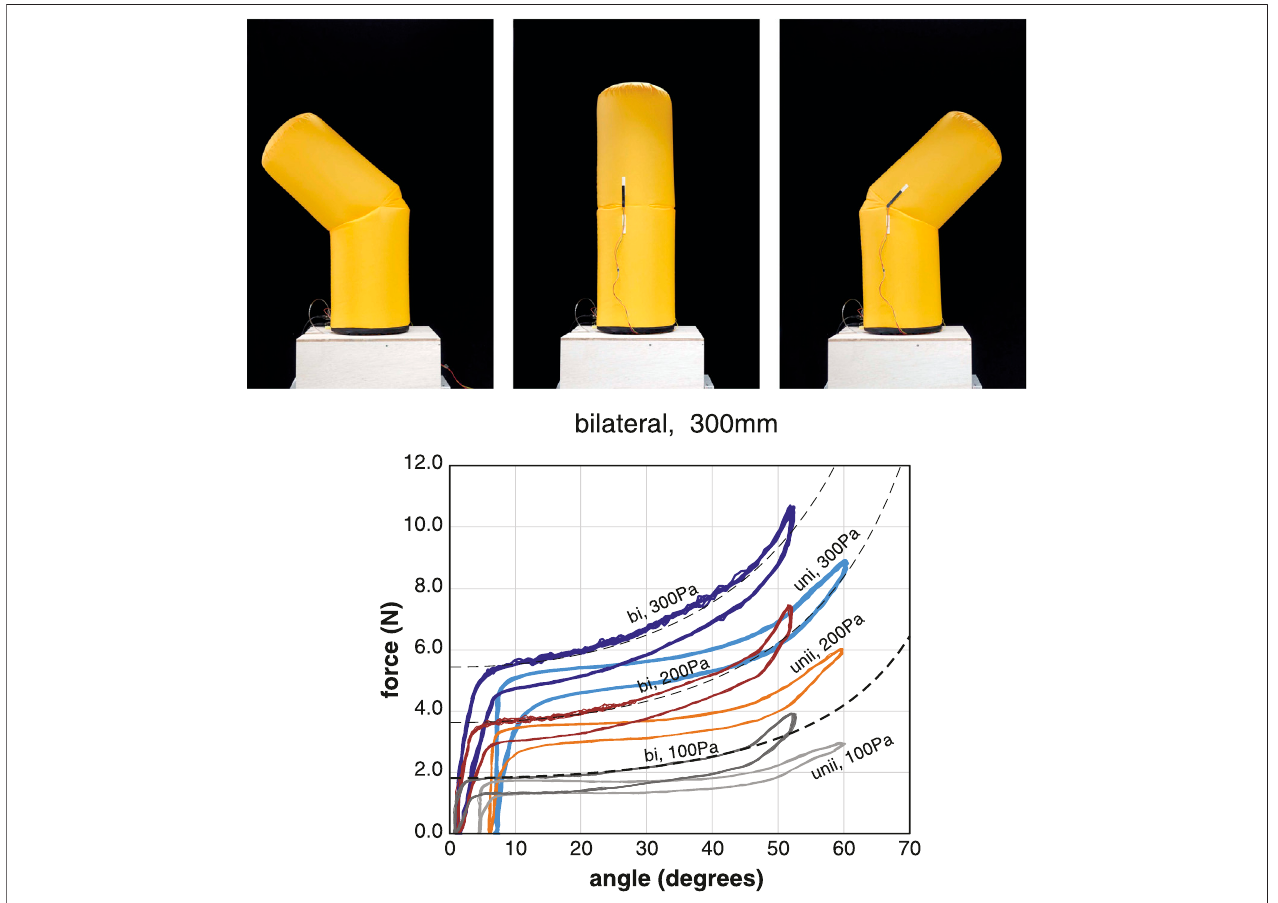
FIGURE 6 | Relationships between the tensile force and angle of bilateral joints under constant pressure conditions. The dotted line represents the theoretical model ofthe bilateral joint.The data ofthe unilateraljoints arealso included for comparison. The in fl atables used for the measurement were the B300and U300. Plots of 10 cycles at the pressure condition of 100Pa, 200Pa, and 300Pa. The pulling angle of the tendon is 30 ° .